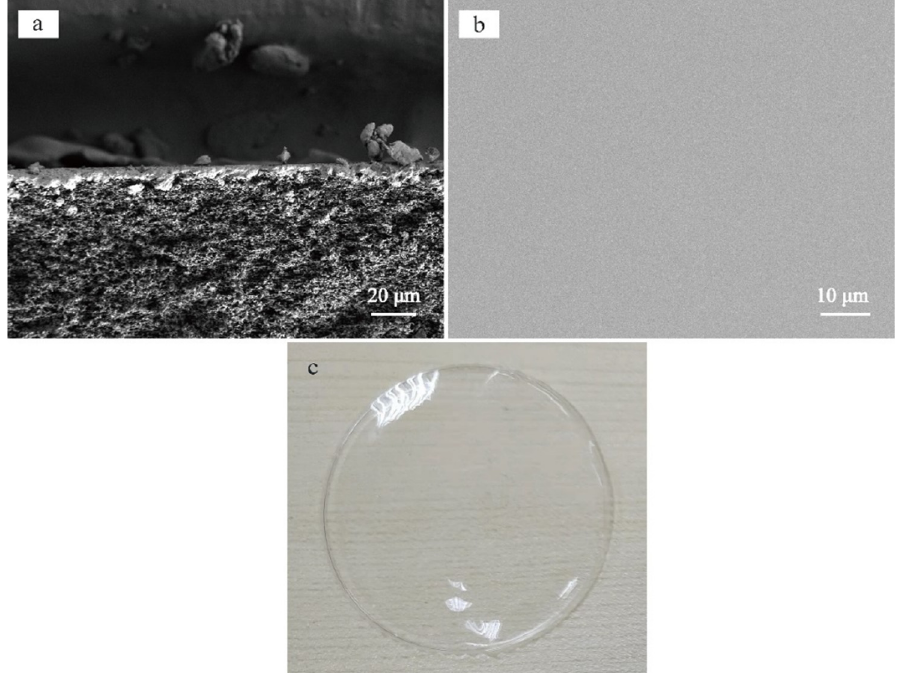
Figure 3. SEM images of the PDMS/PVDF membranes and photographs of the pure PDMS mem- branes without coating on PVDF supports: ( a ) cross-sectional SEM images; ( b ) top-view SEM images; and ( c ) photographs of the PDMS membranes.